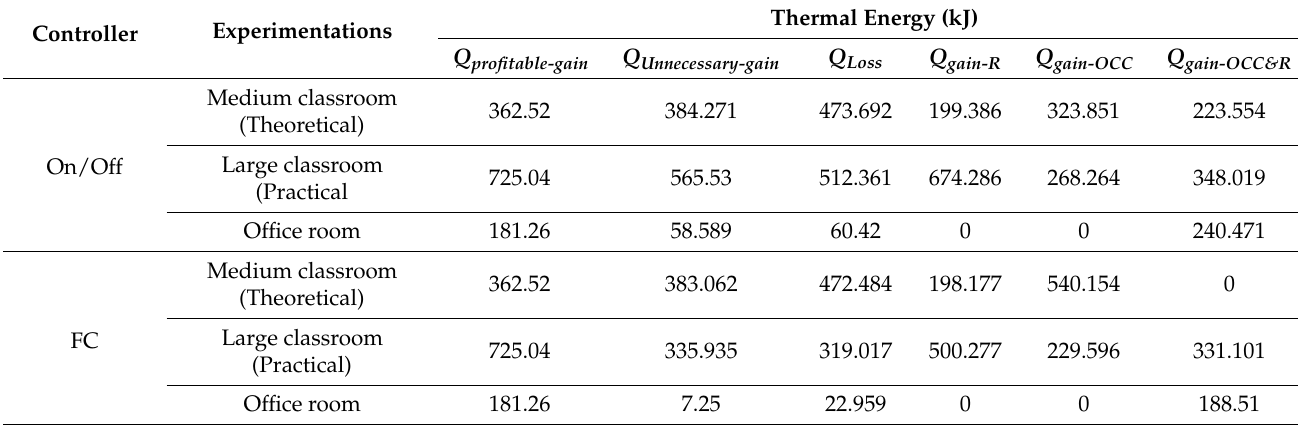
Table 3. The portion of thermal energy that is gained or lost in kilo-joule (kJ) in the living spaces. Controller